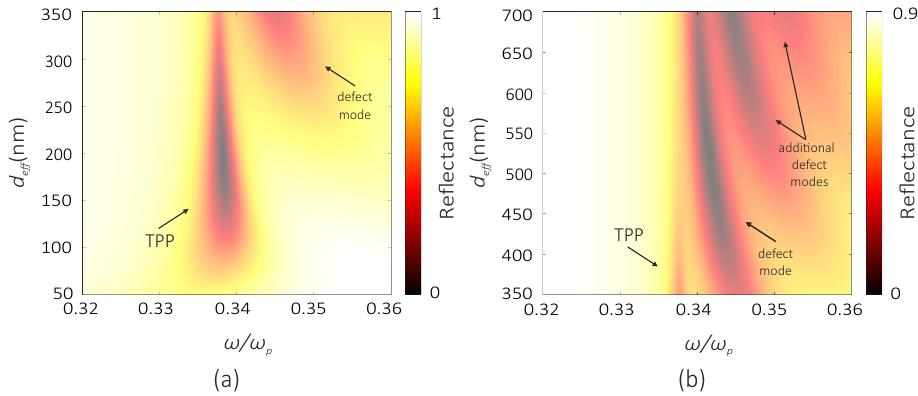
Figure 5. Reflectance spectra of the PhC/nanocomposite structure at the normal incidence of light onto the sample with nanocomposite film thicknesses in the ranges of: ( a ) 50 nm < d eff < 350 nm; and ( b ) 350 nm < d eff < 700 nm. The filling factor is f =